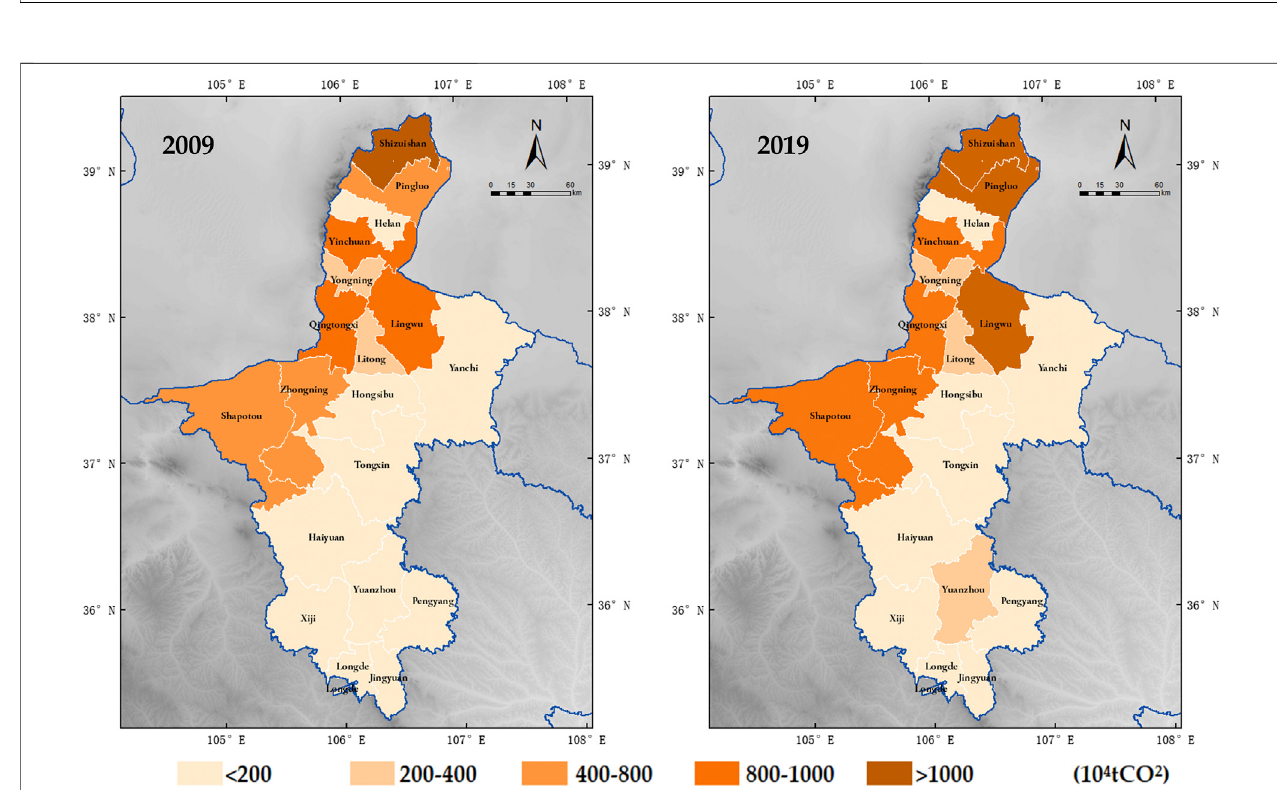
FIGURE 3 | Spatial and temporal distribution of carbon emission in Ningxia, 2009 –